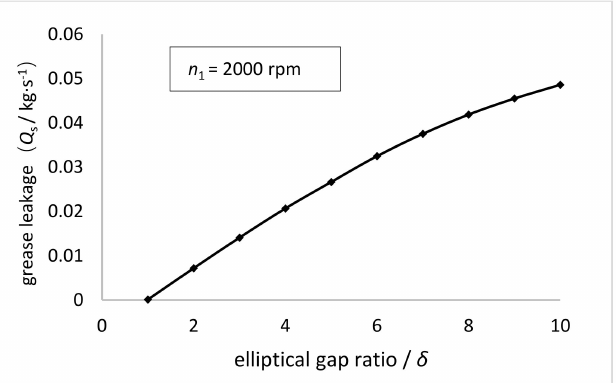
Figure 6. Variations of the grease leakage with the elliptical gap ratio ( n 1 = 2000